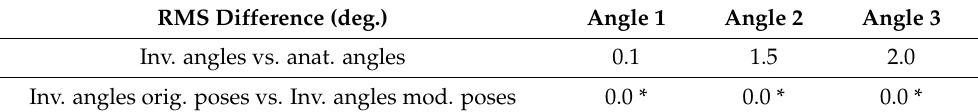
Table 2. Root-mean-squared differences between (i) the invariant angles and anatomical angles and (ii) the invariant angles calculated based on the original measured poses and the ones calculated based on the randomly modified poses. * Values obtained up to a machine precision of 1 × 10 − 13 . RMS Difference (deg.)